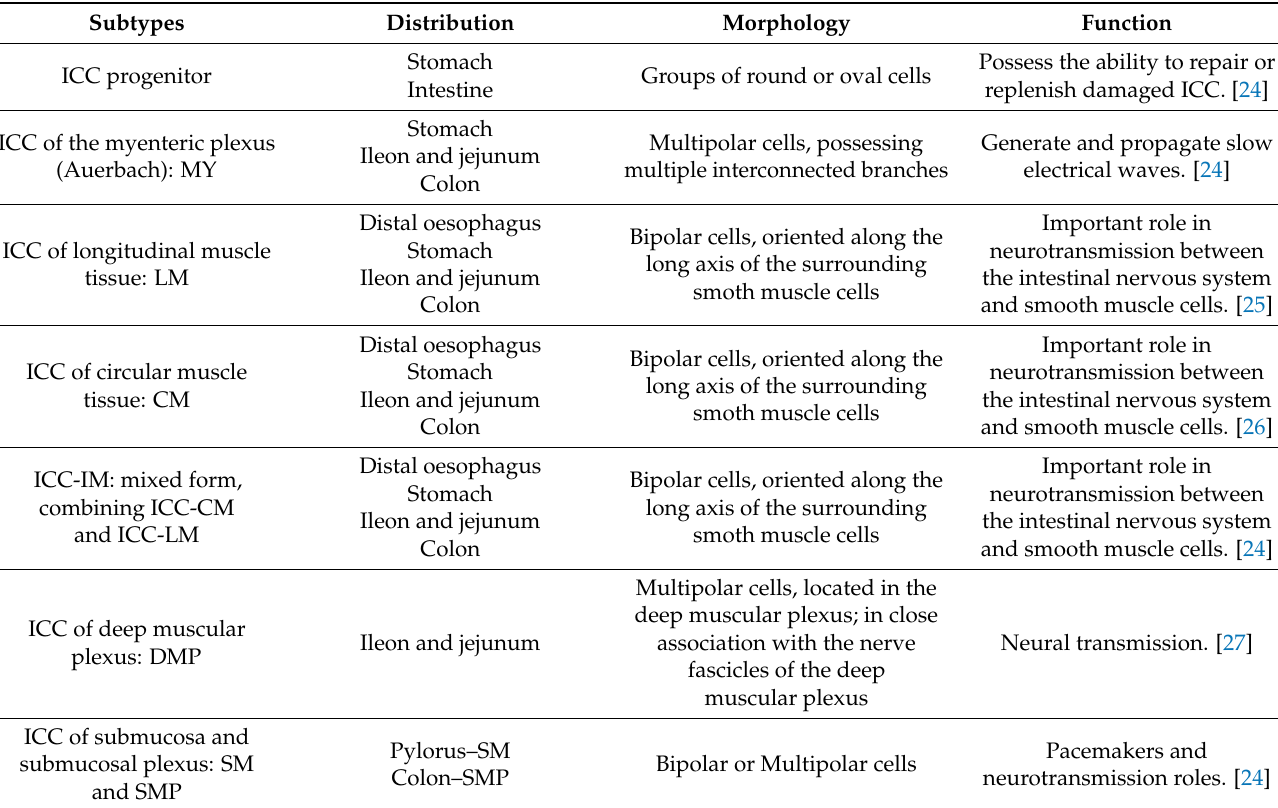
Figure 1. Distribution of the ICC. Table 1. Features of the ICC subtypes.